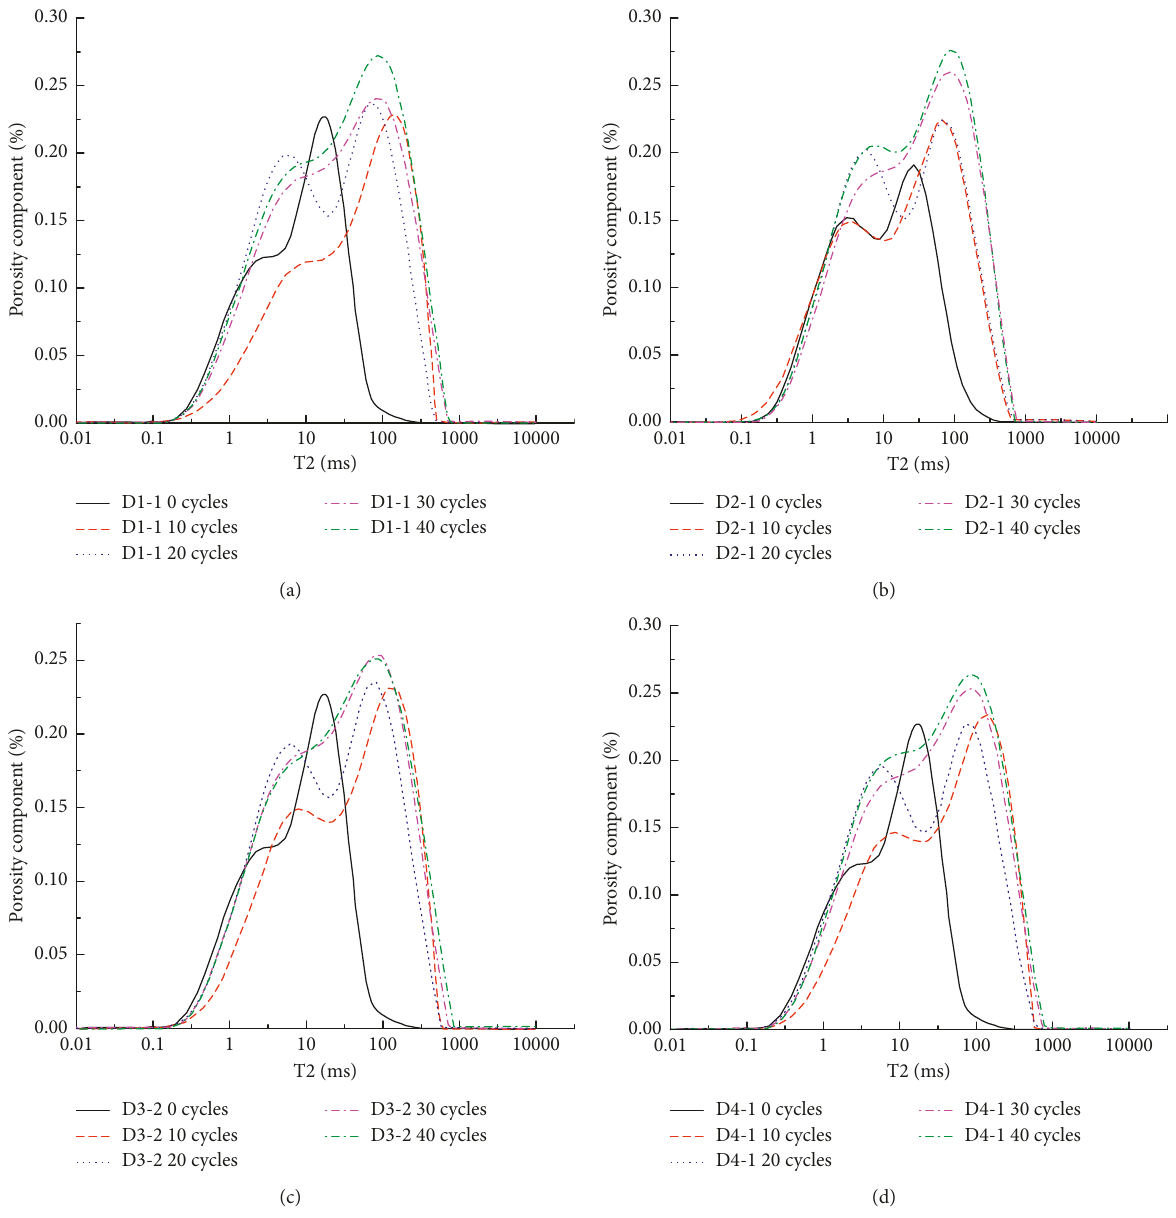
Figure 6: T2 spectrum of sandstone that underwent coupled effect of acid corrosion and recurrent F-Tcycles. (a–d) Samples immersed in solution with pH of 2.8, 4.2, 5.6, and